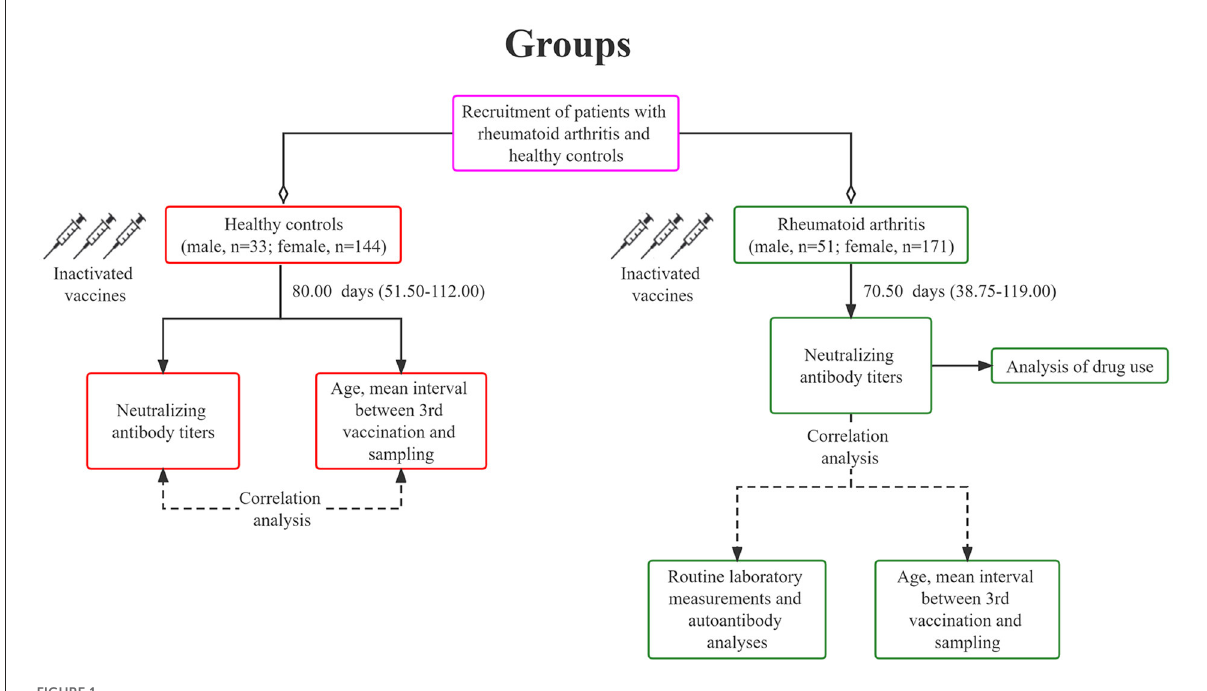
FIGURE1 A standard flow diagram for this